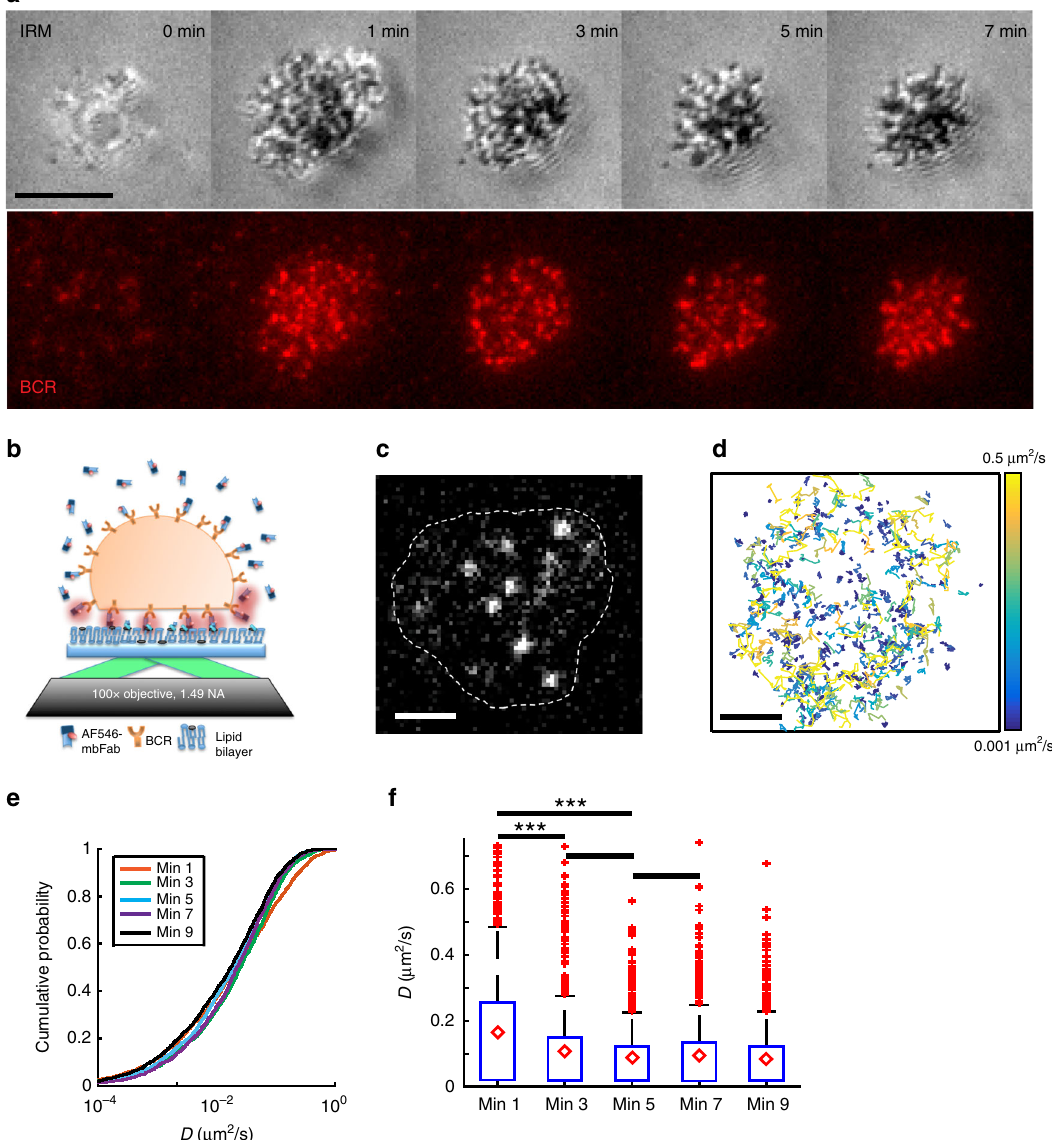
Fig. 1 Single-particle tracking reveals wide range of BCR mobility. a Panel showing primary murine B cell spreading (IRM, above) and BCR clustering (TIRF, below). Scale bar is 3 μ m. b Experimental schematic, indicating activated murine primary B cells, placed on supported lipid bilayers coated with mono-biotinylated fragments of antibody (mbFab). Cells are imaged in TIRF mode and the concentration of AF546 labeled mbFab is kept low enough to image single-molecule events. c Representative TIRF image with the bright dots representing single BCR molecules. The cell contour is obtained from an IRM image taken after TIRF imaging. Scale bar is 1 μ m. d The collection of tracks obtained for a control cell during a 10-min period imaged at 33 Hz for 1000 s every minute. The tracks are color coded for diffusivity. Scale bar is 1 μ m. e Cumulative distribution function (CDF) for the diffusivities measured at 1, 3, 5, 7, and 9 min after activation for BCR in B cells from control mice. f Boxplot showing BCR diffusivities at the indicated time points ( N = 15 cells). The mean is marked with red diamonds, the bottom line represents the lower quartile, the upper line the upper quartile, the whiskers show the extent of the rest of the data, and red crosses are the outliers. Signi fi cance of differences was tested using the Kruskal – Wallis test ( ***p < 0.001; 1 min vs 3 min, p = 0.0008; min 1 vs min 5 , p = 0.000038; min 3 vs min 5 , p = 0.1767; min 5 vs min 7 , p = diffusive modes and the high heterogeneity of the cell membrane states only 15 . Fig. 2a shows representative trajectories assigned to by splitting trajectories into shorter segments and identifying each state. transitions between different diffusive states across segments. All In control cells, all eight states displayed simple diffusion, as single-molecule trajectories were split into 15-frame segments shown by the ensemble mean-square displacement (eMSD) plots and the classi fi cation analysis was performed on the set of all of (Fig. 2b). For all states, the representative mean diffusivity was these 15-frame-long tracks. pEM analysis of all BCR trajectories preserved over time (Fig. 2c). For each time point, we calculated from B cells identi fi ed eight distinct states, revealing a far greater the fraction of tracks assigned to each state — the population complexity of diffusive behavior than is apparent from approa- fraction (Fig. 2d). The population fraction of the fastest moving ches that average over all tracks or that impose two diffusive state, State 8, rapidly decreases within the fi rst few minutes and